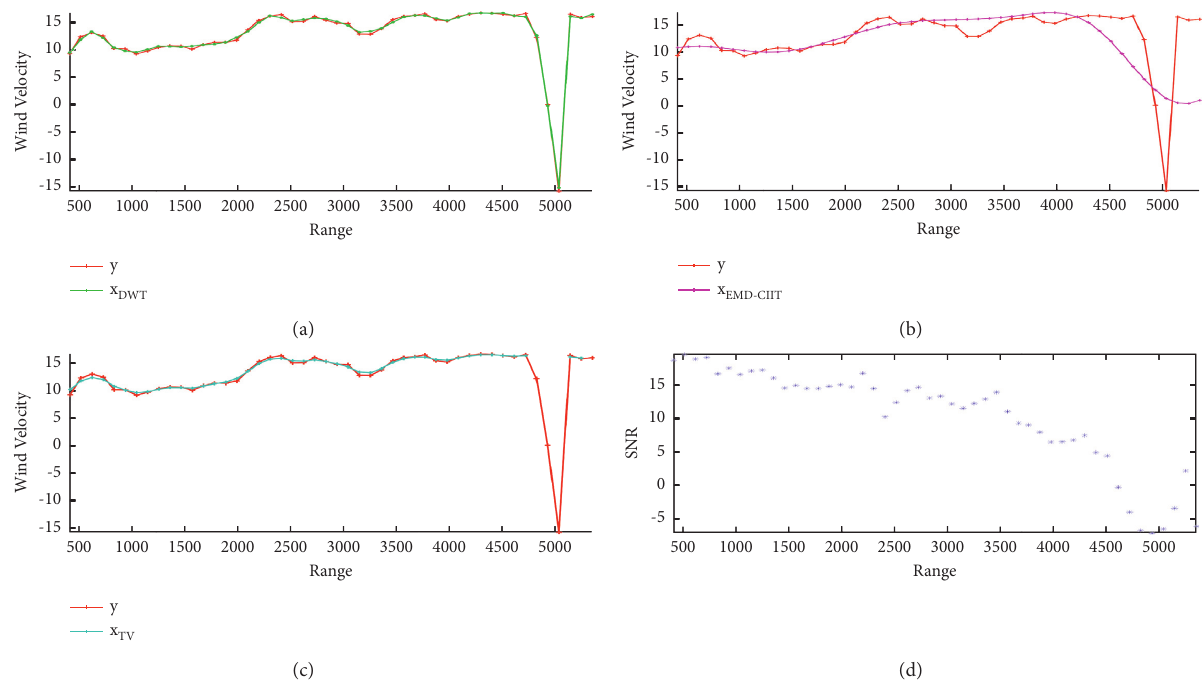
Figure 4: The denoising results by the “DWT” (a), “EMD-CIIT” (b), and our proposed scheme (c) for the LiDAR data collected on 4 March 2015 from 21 :26:16 to 21 :46: 39 with a fixed azimuth angle (314 . 0 ° ). The SNR values of the corresponding observed LiDAR data are shown in the